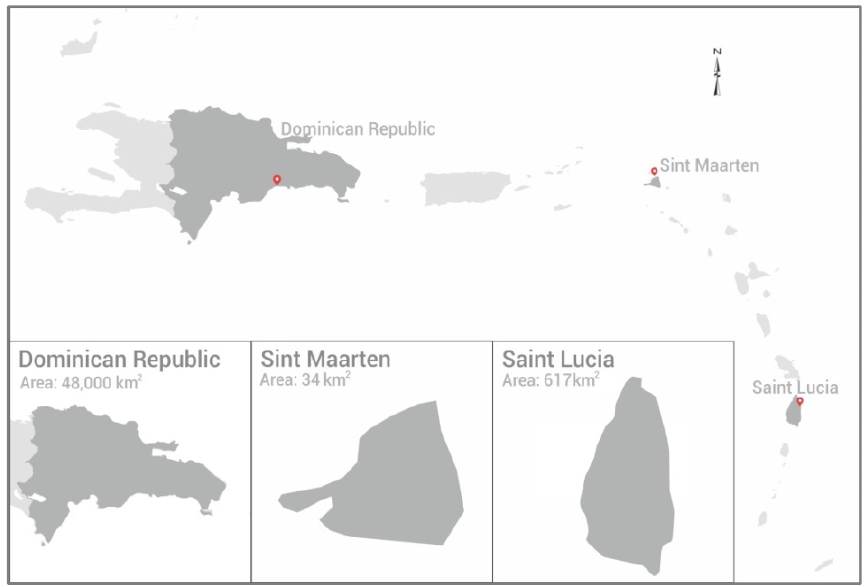
Figure 2. Location of selected countries: the Dominican Republic, St. Maarten and St. Lucia. Caribbean countries are extremely vulnerable to climate change and natural disas- ters. The impact of hurricanes and floods alone in the region is approximately 2 percent of GDP per year [24]. For instance, in Sint Maarten alone, Hurricanes Irma and Maria (2017) caused an estimated physical damage of more than USD 1.l8 billion [3].